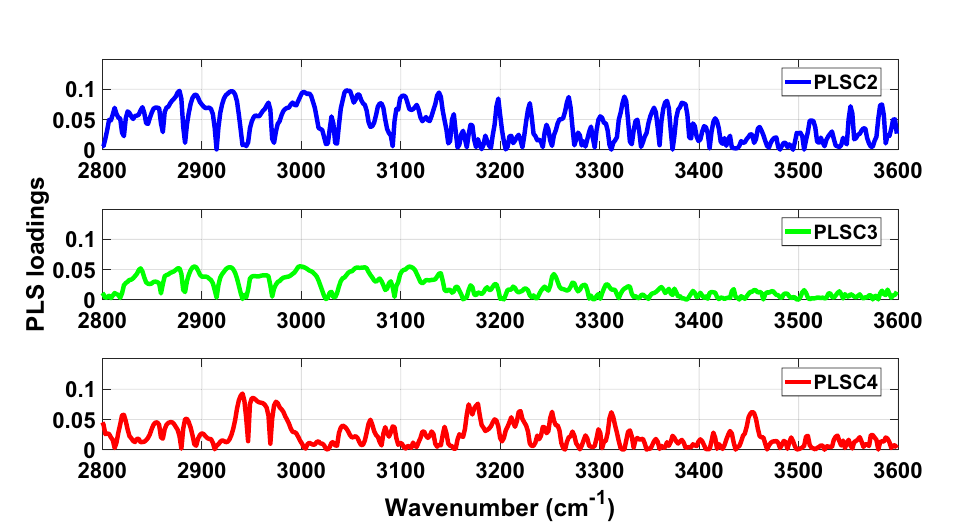
Figure 4. Absolute values of PLS loadings of PLSC2 (blue), PLSC3 (green) and PLSC4 (red) in the high wavenumber spectral region between 2800–3600 cm −1 for our analysis of the LIQUID 1